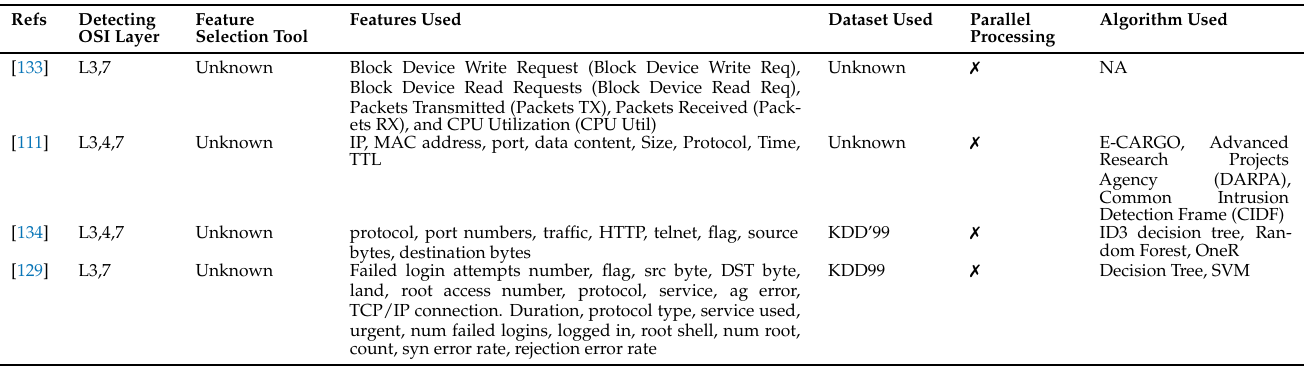
Table 12. Hybrid-based DDoS detection approaches on CC.